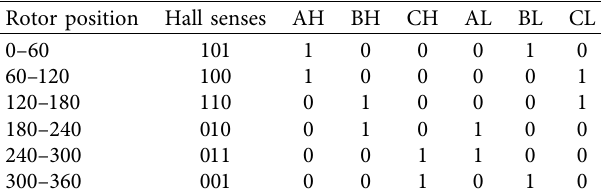
Table 2: Commutation technique for the BLDC